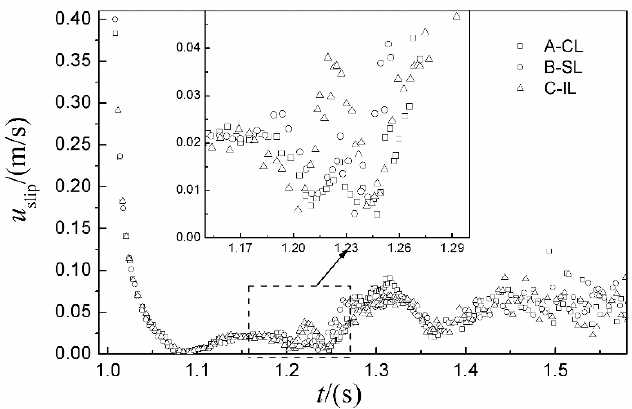
Figure 10. Effects of Cr on particle slip velocity.